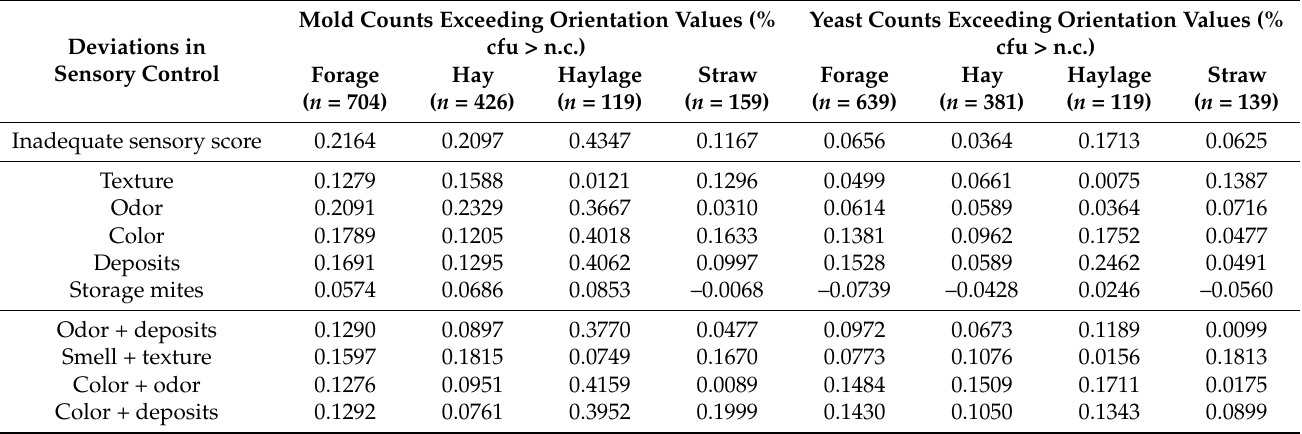
Table 8. Agreement of deviations in sensory control (single parameters and combinations of param- eters) and counts of molds or yeasts exceeding the orientation values (according to VDLUFA [51]; calculation of Cohen’s Kappa) in different forage